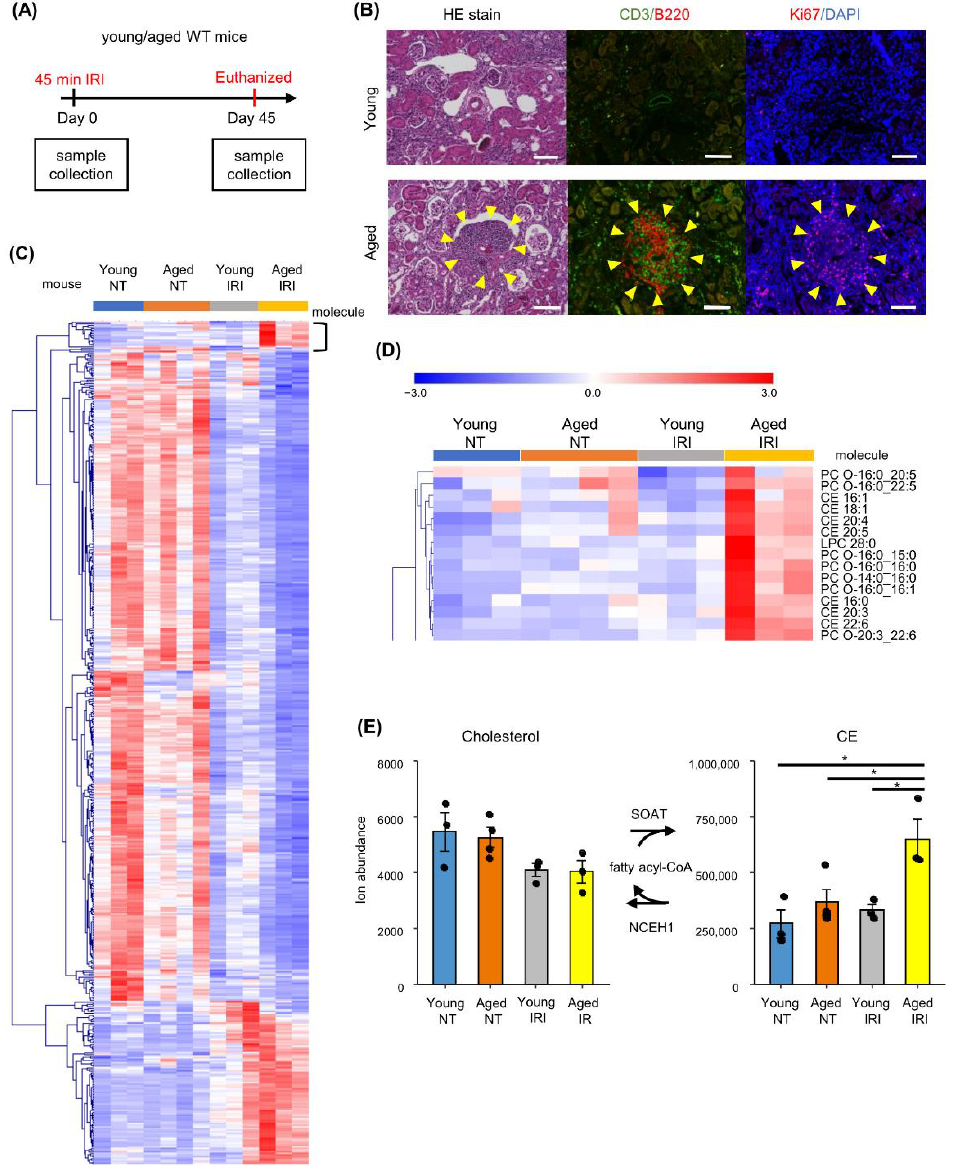
Figure 2. Untargeted lipidomics of aged and young mice kidneys with/without IRI. ( A ) Experimental protocol of lipidomic analysis. ( B ) Hematoxylin and eosin staining and protocol of lipidomic analysis. ( B ) Hematoxylin and eosin staining and immunofluorescence of kidney immunofluorescence of kidney section from young (8-week-old) and aged (12-month-old) mice section from young (8-week-old) and aged (12-month-old) mice after 45 min IRI. Yellow arrows after 45 min IRI. Yellow arrows indicate TLT. Scale bars: 100 μm. ( C ) Cluster analysis of molecules indicate TLT. Scale bars: 100 µ m. ( C ) Cluster analysis of molecules significantly changed among significantly changed among groups ( n = 3 – 4 for each group) by one-way analysis of variance ( p < groups ( n = 3–4 for each group) by one-way analysis of variance ( p < 0.05, 511 molecules). Intensity 0.05, 511 molecules). Intensity of each molecule was converted to z-score and displayed as a of each molecule was converted to z-score and displayed as a heatmap. Detailed data of clustered heatmap. Detailed data of clustered molecules are reported in Data S1A,B. ( D ) Cluster that molecules are reported in Data S1A,B. ( D ) Cluster that contains molecules uniquely increased in aged contains molecules uniquely increased in aged kidneys after IRI. ( E ) Cholesterol and cholesteryl kidneys after IRI. ( E ) Cholesterol and cholesteryl ester (CE) abundance measured by LC–MS/MS. ester (CE) abundance measured by LC –MS/MS. Statistical significance was analyzed with Tukey’s Statistical significance was analyzed with Tukey’s HSD test, * p < 0.05. Abbreviations: NT HSD test, * p < 0.05. Abbreviations: NT non-treated, CE cholesteryl ester, PC-O ether-linked